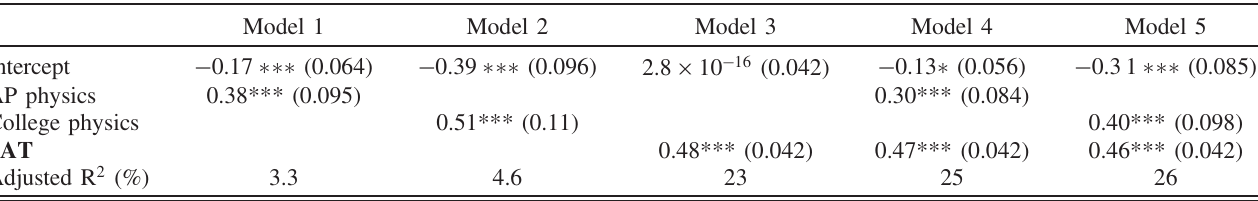
TABLE II. Regression of FMCE prescore on various measures of prior preparation. Each variable is normalized such that the regression coefficients may be interpreted as effect sizes (Cohen ’ s d ). The standard error for each coefficient is given in parentheses. Goodness of fit of the model is determined by adjusted R 2 . (cid:2) p < 0 . 05 , (cid:2) (cid:2) p < 0 . 01 , (cid:2) (cid:2) (cid:2) p < 0 . 001 .